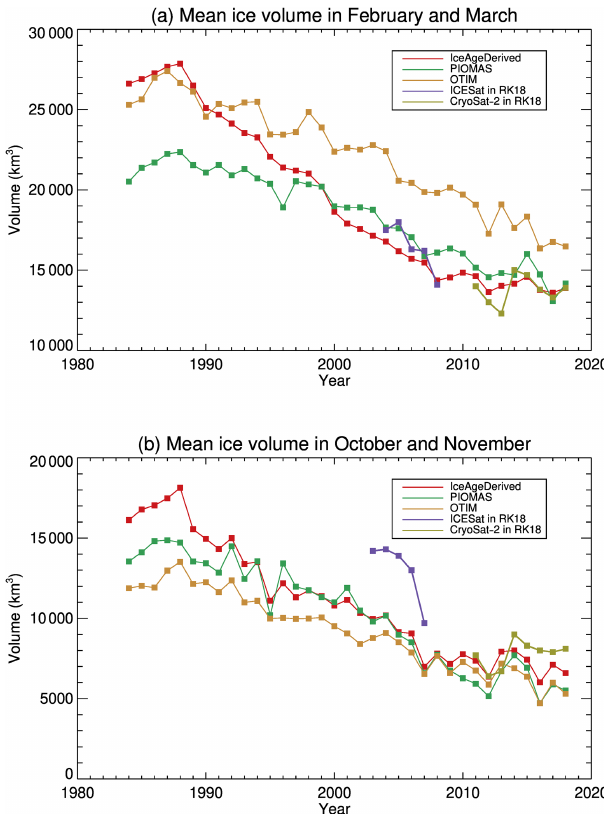
Figure 16. Mean Arctic ice volume in February and March (a) and from October and November (b) from 1984 to 2018, derived from ice age, PIOMAS, OTIM, ICESat (2003–2007), and CryoSat- 2 (2011–2018) over the Arctic Ocean.